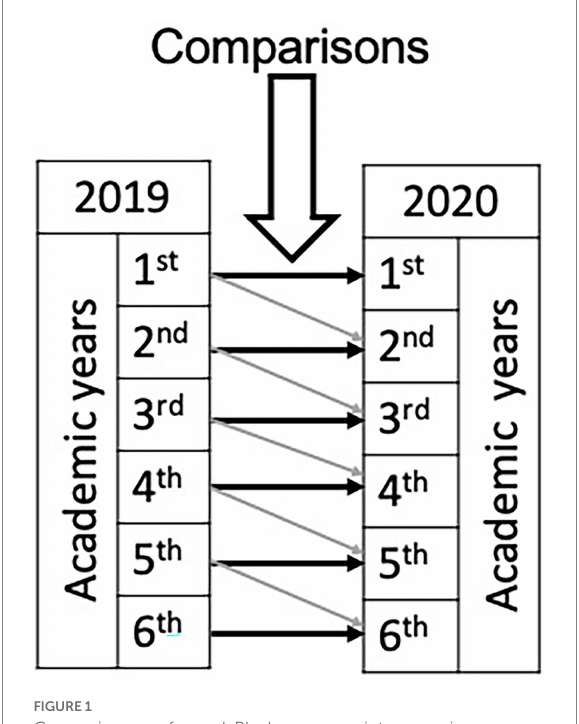
FIGURE 1 Comparisons performed. Black arrows: point comparisons between 2019 and 2020 for each academic year. Grey arrows: comparisons of the same cohort on subsequent academic